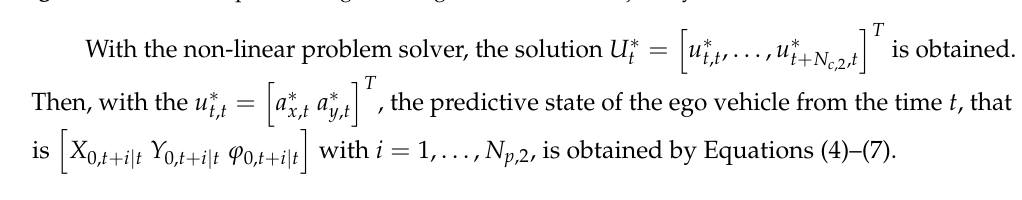
Figure 10. The whole process of generating local reference trajectory.